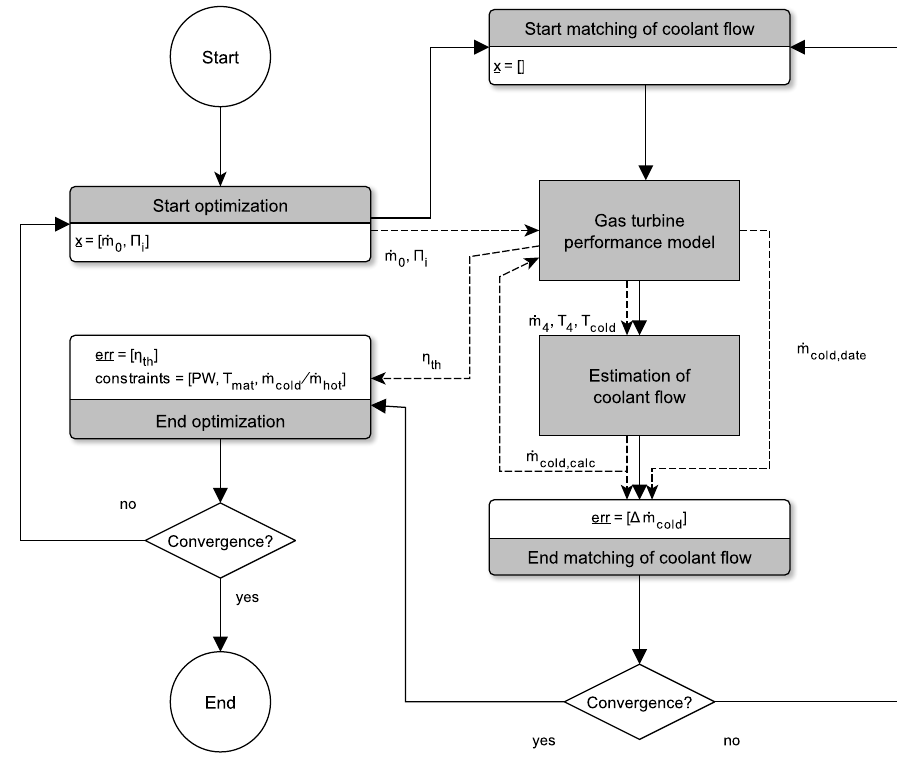
Figure 3. Optimization